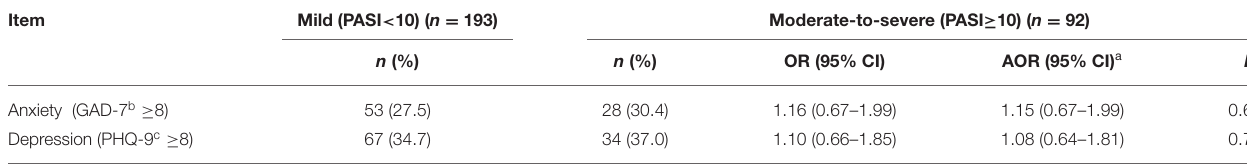
TABLE 5 | Subgroup analysis for the association between depression and anxiety the participants among two groups by PASI score.